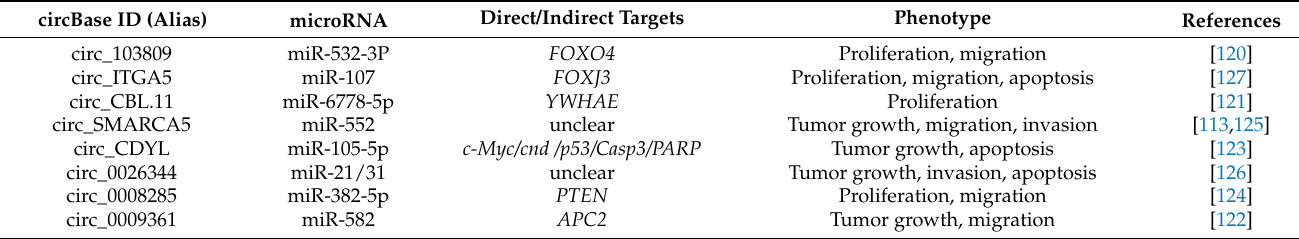
Table 4. The sponge function of tumor-suppressor circRNA in